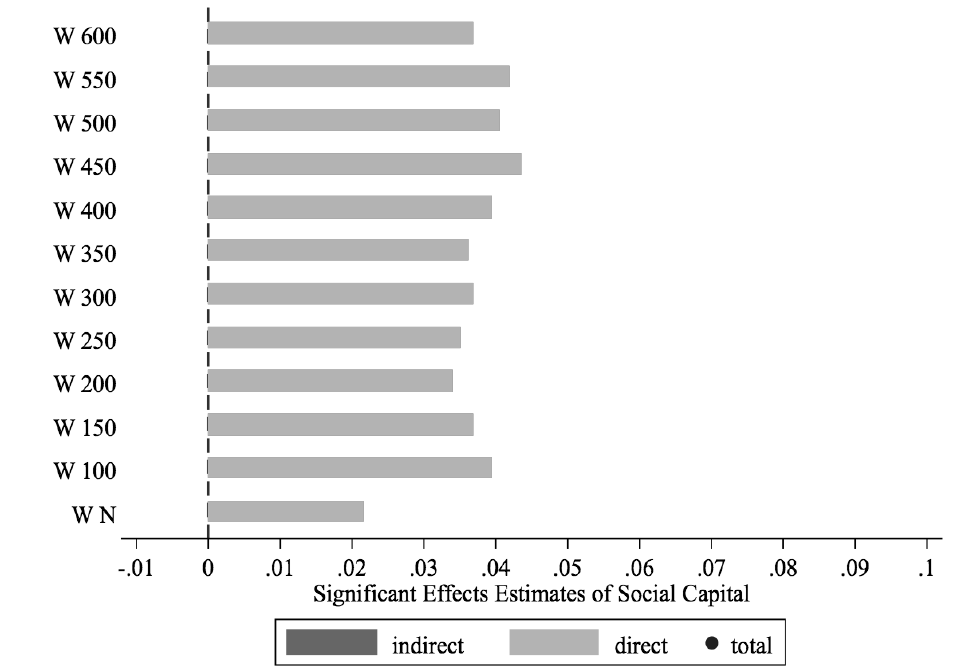
Figure 6: Significant effect estimates of social capital for all spatial weighting matrices (SDM)